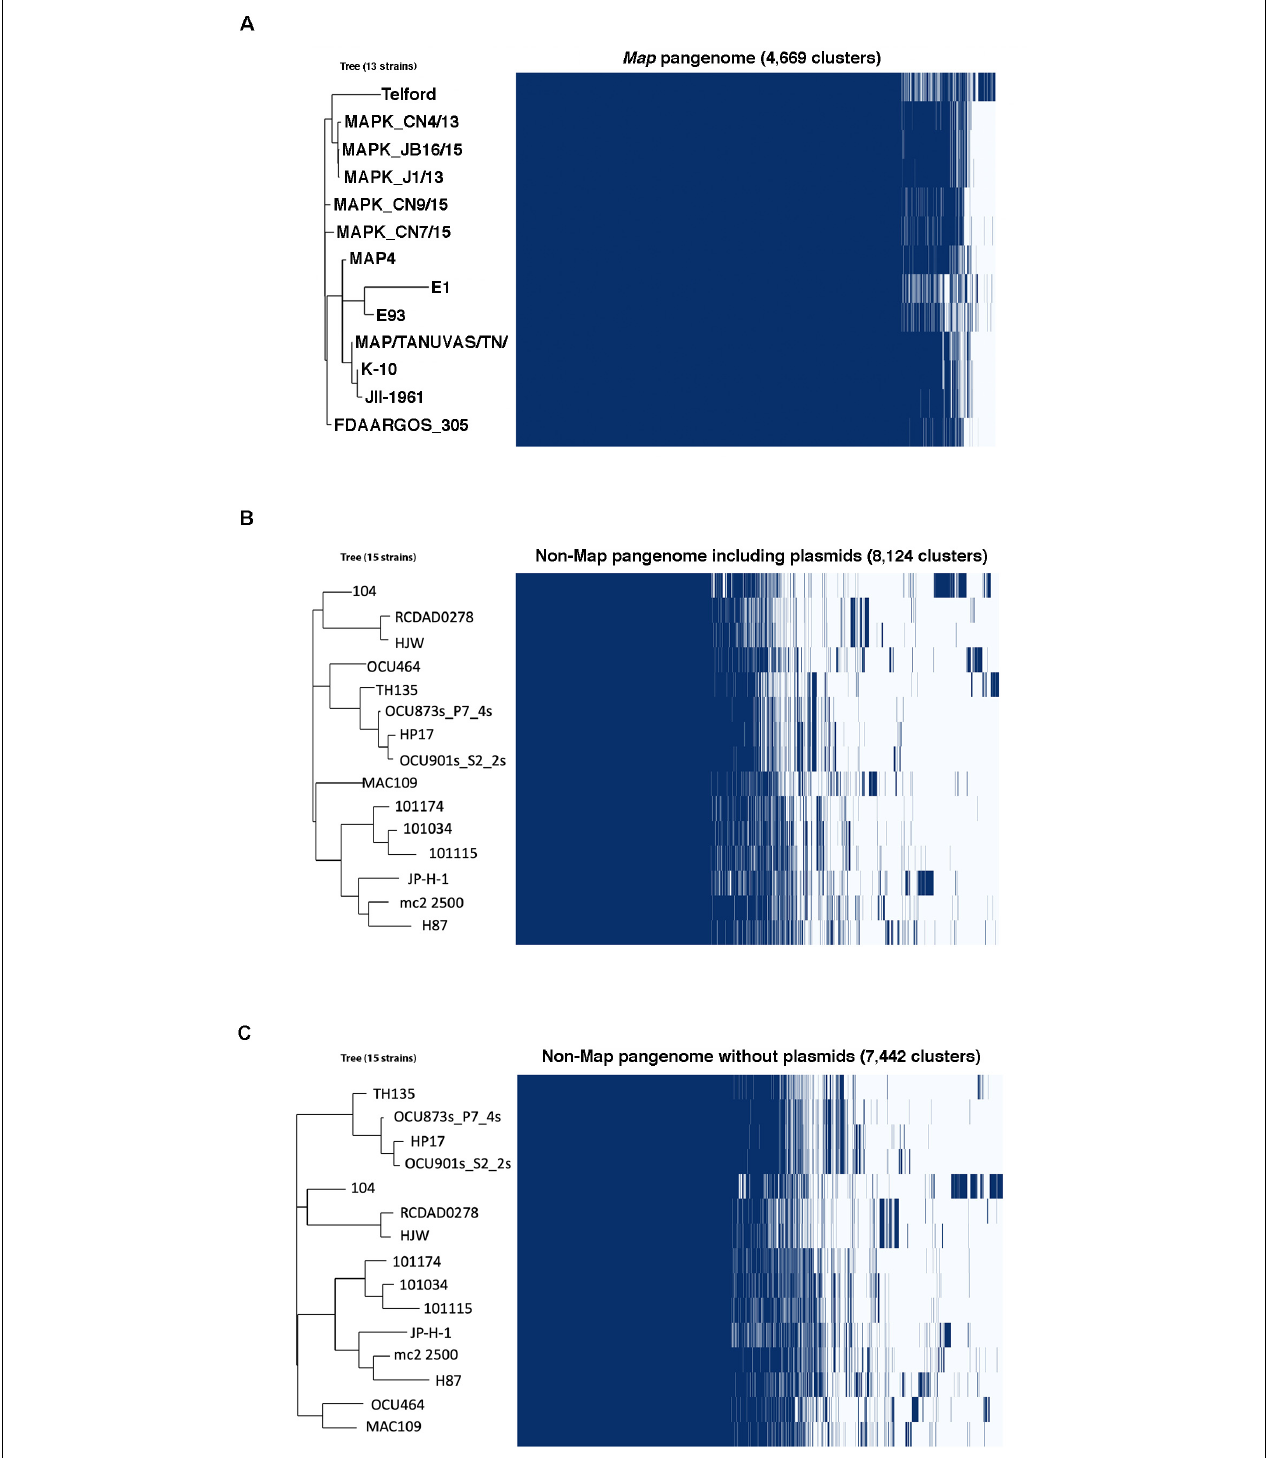
FIGURE 6 | Gene presence matrix of the Map (A) and non- Map pangenomes analyzed with (B) and without (C) plasmid DNA elements. At the right of each panel is a compressed gene cluster matrix where blue blocks indicate presence of the gene in that cluster and white indicates its absence. Each column represents an orthologous gene family. The corresponding phylogenetic tree is presented on the left and strains listed on the tree correspond to each row of the matrix. Only the phylogeny of OCU464 is affected by the presence/absence of plasmid DNAs among the non- Map strains (compare B and C ). Note the discrepancy of the core genome between Map and non- Map . Fully 80% of the Map genome consists of core